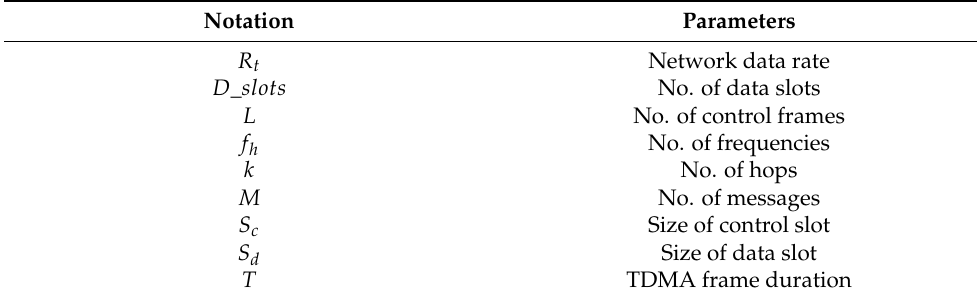
Table 10. Parameters and their notation.